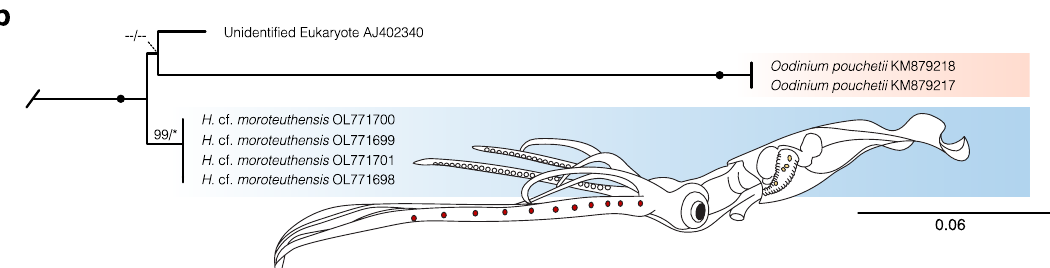
Figure 2. Maximum Likelihood (ML) phylogeny of H. cf. moroteuthensis 18S rRNA (blue), showing taxonomic affinities to select sequences from the ( a ) DINOREF database 32 and ( b ) GenBank Blastn matches. Parasitic taxa are highlighted with color blocks, including Oodinium pouchetii from the larvacean Oikopleura sp. (orange) 41 . The DINOREF tree was trimmed from 794 to 40 sequences to better show details of the larger monophyletic clade comprising H. cf. moroteuthensis in addition to the outgroup. The Blastn tree was trimmed to show only the smallest monophyletic clade with 90–98% genetic similarity between sequences. Nodes show posterior probabilities (PP)/ bootstrap (BS) values from the Bayesian Inference and ML analyses, respectively. Low support or no values (> 0.95 pp or > 70% bs) are indicated with two dashes